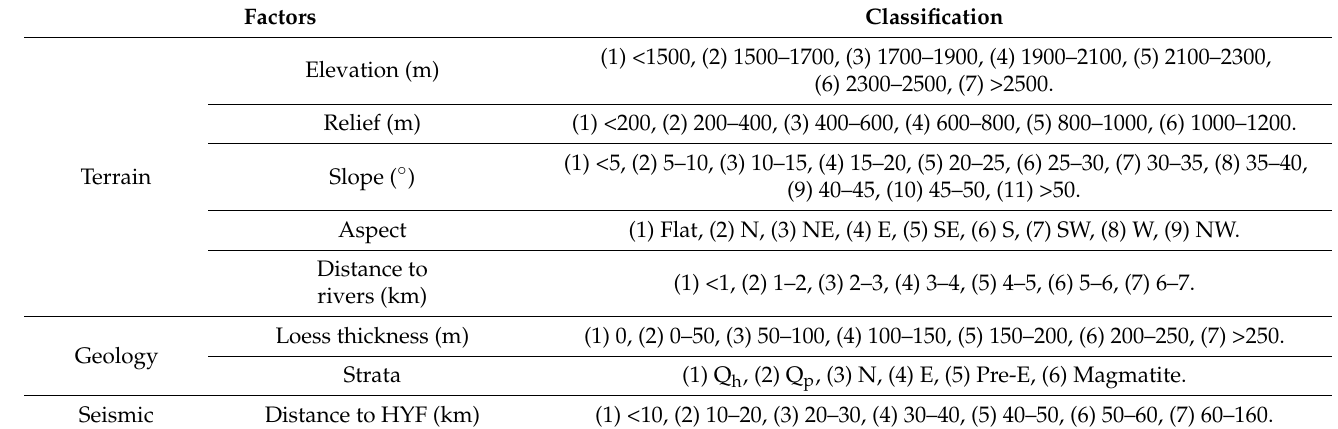
Table 1. Classification of the terrain, geology, and seismic factors used in the spatial distribution analysis.